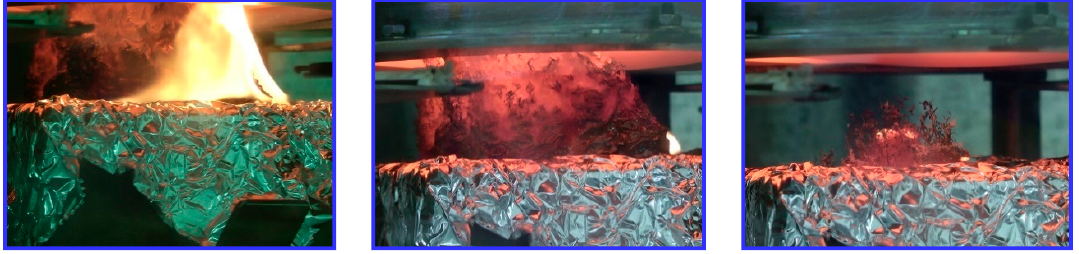
Figure 13. Photographs of PEEK under 60 kW / m 2 at ( left ) 382 s, ( middle ) 756 s and ( right ) at the end of the test.